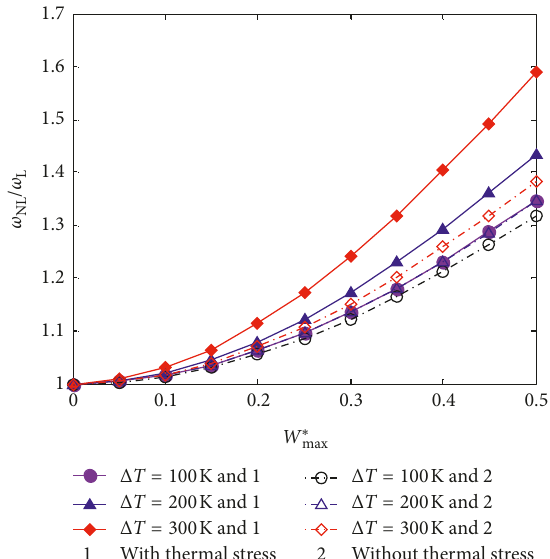
Figure 5: The effect of the temperature rise together with the initial thermal stress on the nonlinear frequency ratio of FG-CNTRC beams ( H 10 ,K S 0 . 1, and (cid:29)